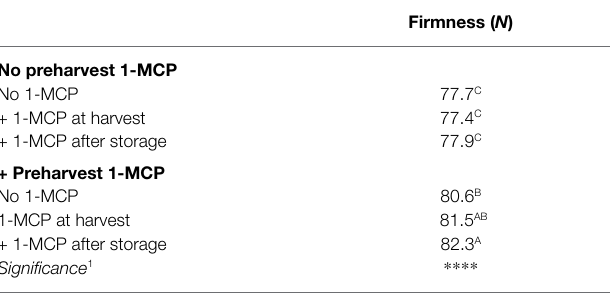
TABLE 5 | Internal ethylene concentration of ‘Gala’ apples treated without or with preharvest 1-MCP orchard spray at 7 days before harvest in combination without or with postharvest 1-MCP (1 μ l L -1 ) for 24 h at harvest or after storage in 1.5 or 0.6 kPa O 2 + <0.5 kPa CO 2 at 0.5 ° C for 9 months in Year 1.